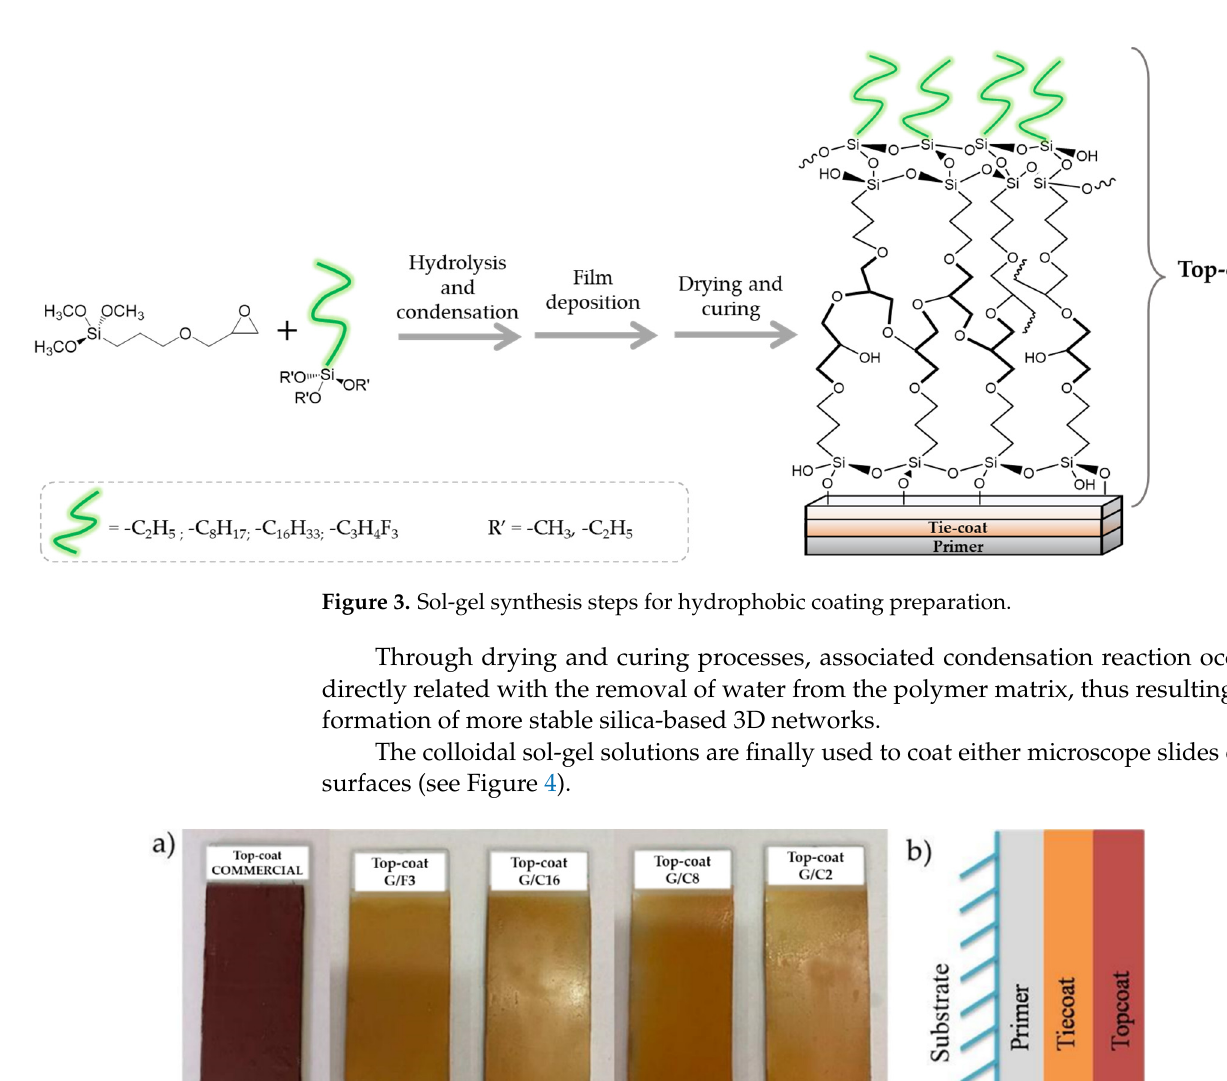
Figure 6. FT-IR spectra of glass slides treated with G and G/F3 sol ( a ) and G/C2, G/C8 and G/C16 sol ( b ). In the coating realized by adding a fluorinated precursor, such as trifluorobutyl-tri- methoxysilane (F3) to the 3-Glycidyl-oxypropyl-trimethoxysilane (G), the occurrence of fluorine was confirmed by the variation in spectra in the range of 1100–1270 cm − 1 , owing